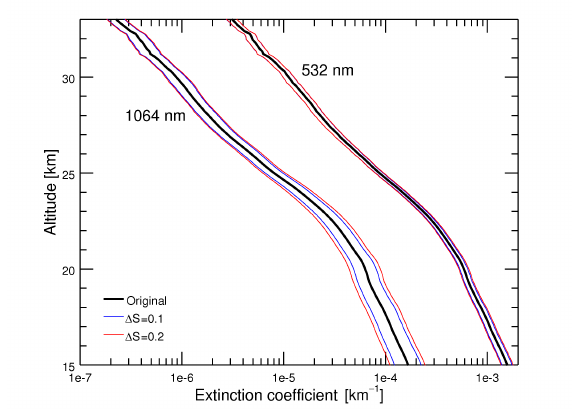
Figure 10. Relative error of the extinction coefficients ( ∆ k sca and 532nm. The impact of uncertainties in refractive index, temperature, pressure, distribution width ( ∆ S ) and measurement errors are shown for monthly mean measurements of March 2013.